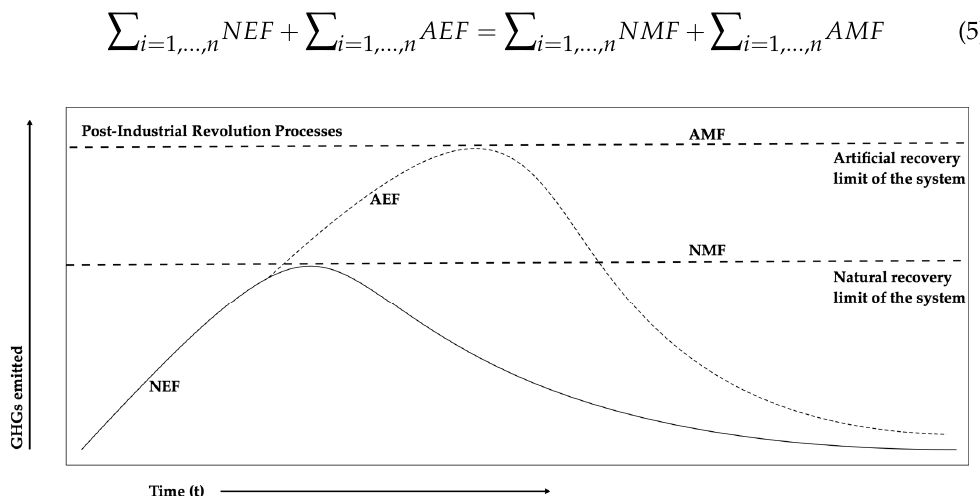
Figure 7. Resilience of the Earth system with the inclusion of anthropogenic (artificial) measures to mitigate greenhouse gas emissions (NEF—Natural GHGs Emission Factors; NMF—Natural GHGs Mitigation Factors; AEF—Anthropogenic GHGs Emission Factors; AMF—Anthropogenic GHGs Mitigation Factors).